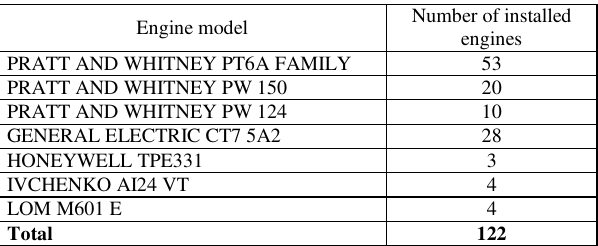
Table 9. Model and number of the turboprop engines